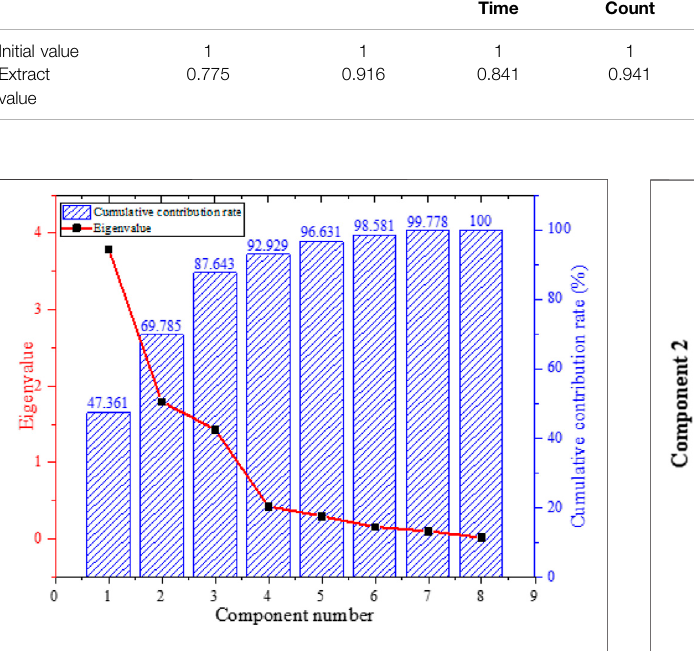
FIGURE 6 | Eigenvalues of principal component analysis.